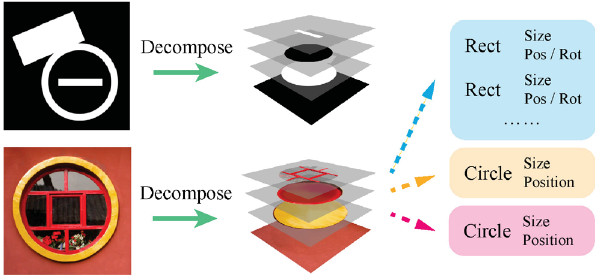
Fig. 1 Motivation: given an image composed of abstract shapes, our framework can decompose overlapping primitives into multiple layers and estimate their